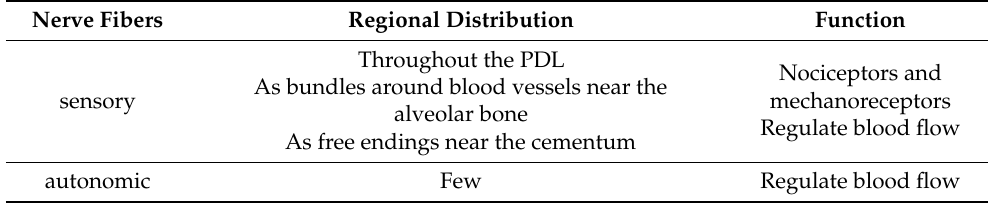
Table 2. Nerves in the periodontal